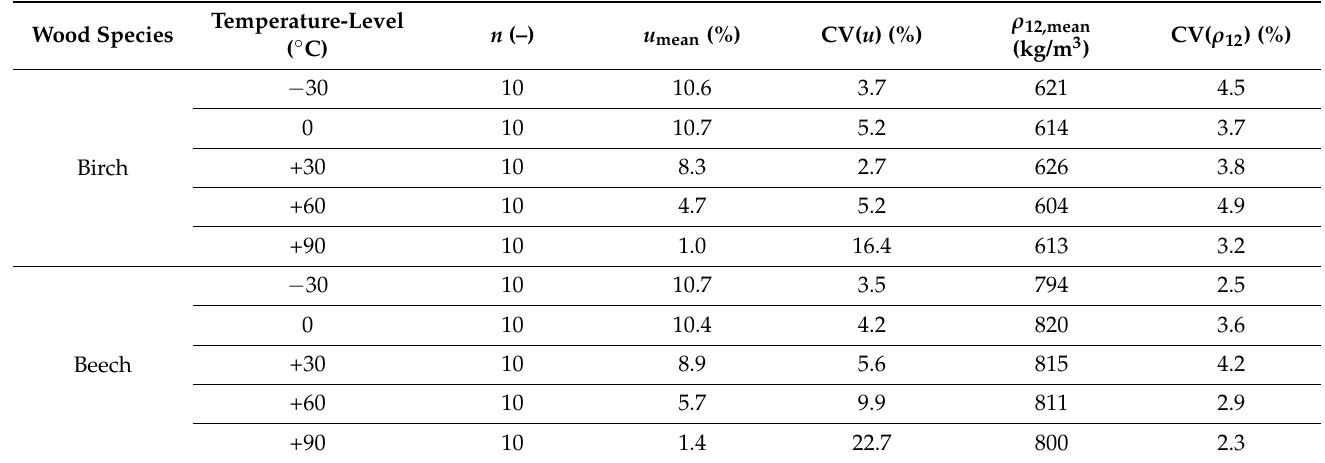
Table 1. Overview of the main statistics regarding moisture content and density adapted to reference moisture condition of u ref = 12% (CV—Coefficient of